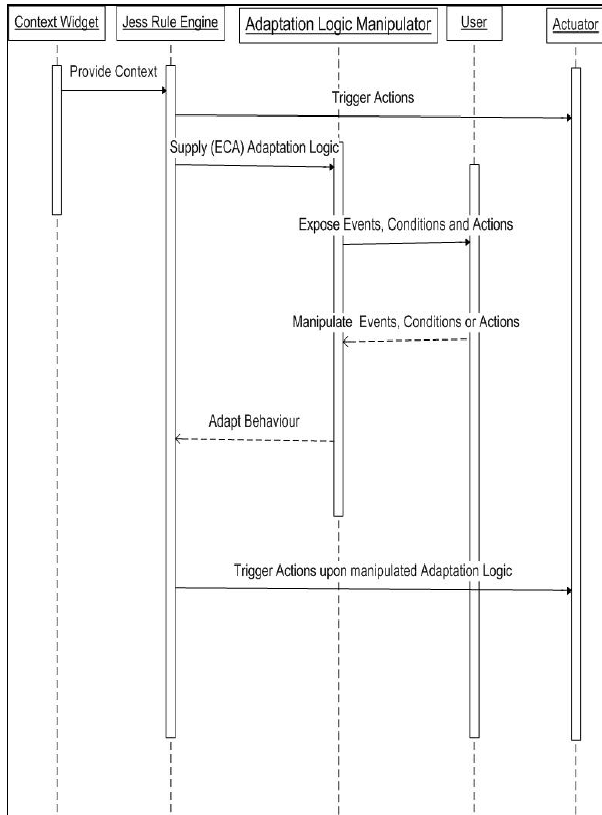
Figure 5. Sequence Diagram for the Adaptation Logic Manipulation